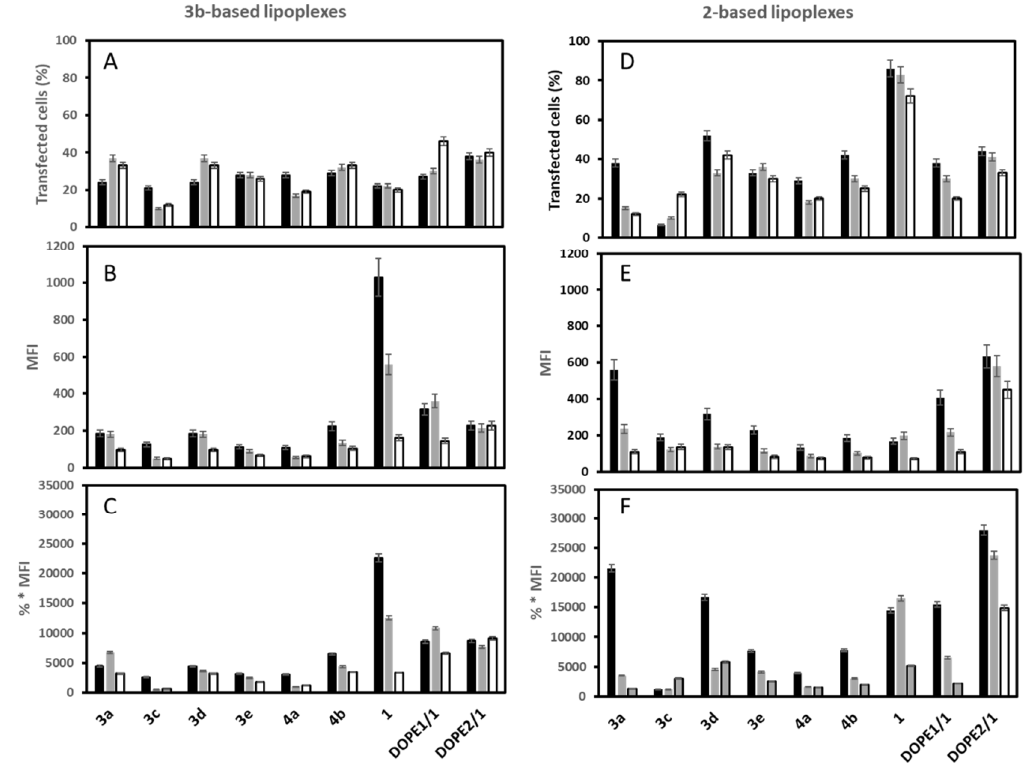
Figure 3. Transfection efficiency of mRNA lipoplexes. DC 2.4 cells were transfected for 4 h with lipoplexes made eGFP mRNA at (black bars) 1/0.5, (grey bars 1/1) and (white bars) 1/2 mRNA/L charge ratio. The expression of eGFP was measured 48 h post-transfection by flow cytometry. ( A , D ) Transfected cell (%) corresponds to the percentage of eGFP positive cells; ( B , E ) MFI is the mean of the fluorescence intensity related to the amount of eGFP produced by the cell; ( C , F ) % * MFI is the global transfection efficiency (i.e., the product of the number of EGFP positive cells by MFI). Values are means ± SD of three different experiments. Table 3. Cell Viability (%) in the presence of mRNA lipoplexes.